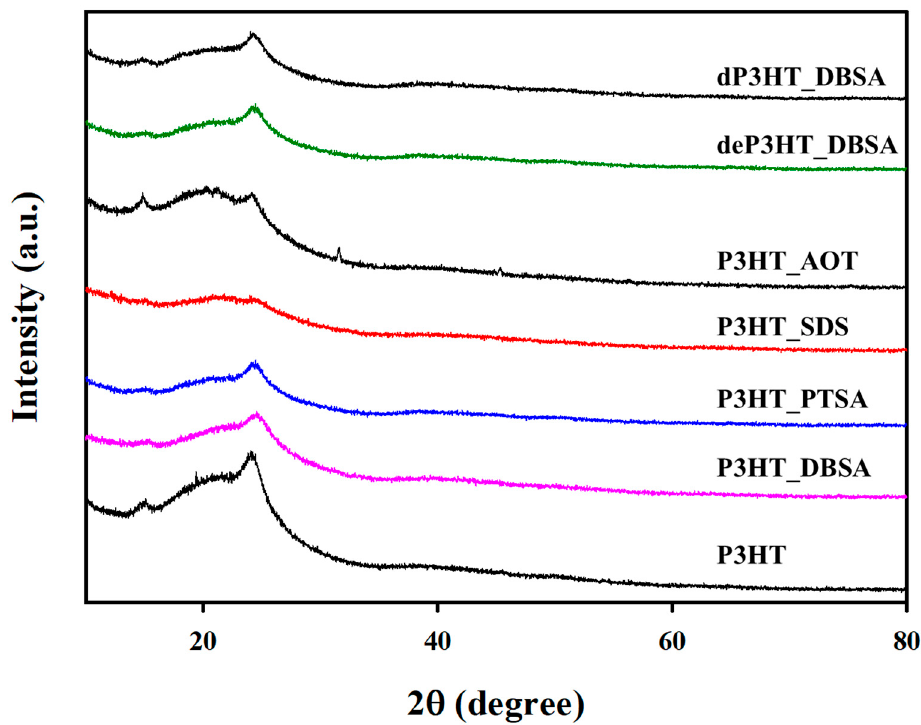
Figure 3. XRD patterns of P3HT synthesized under different conditions: without surfactants; with various surfactants; and before and after the doping process.